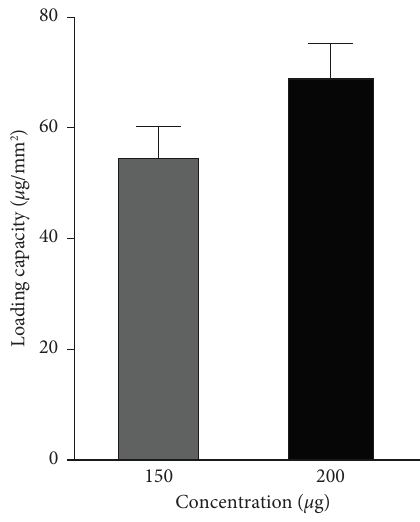
Figure 11: Determination of AgNPs’ loading capacity on DFS scafold at diferent concentrations. Error bars are the standard deviation from triplicate measurements.